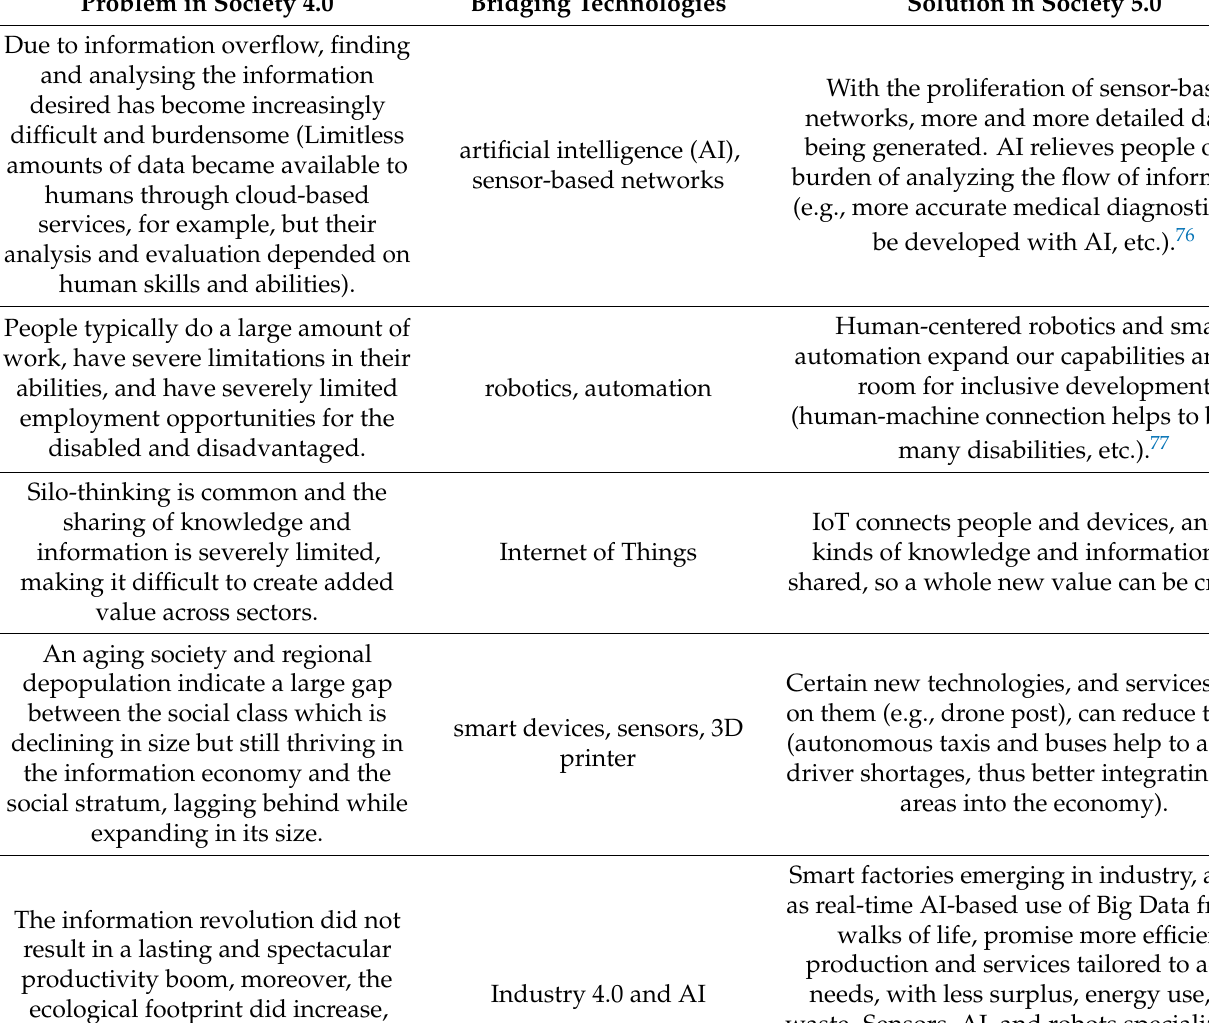
Table 1. Society 4.0 vs. Society